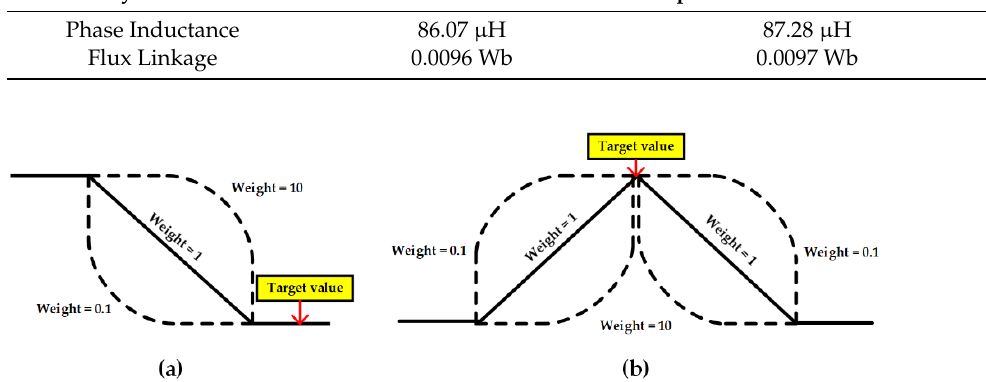
Figure 8. Desirability function for ( a ) smaller the better characteristics and ( b ) nominal is the best